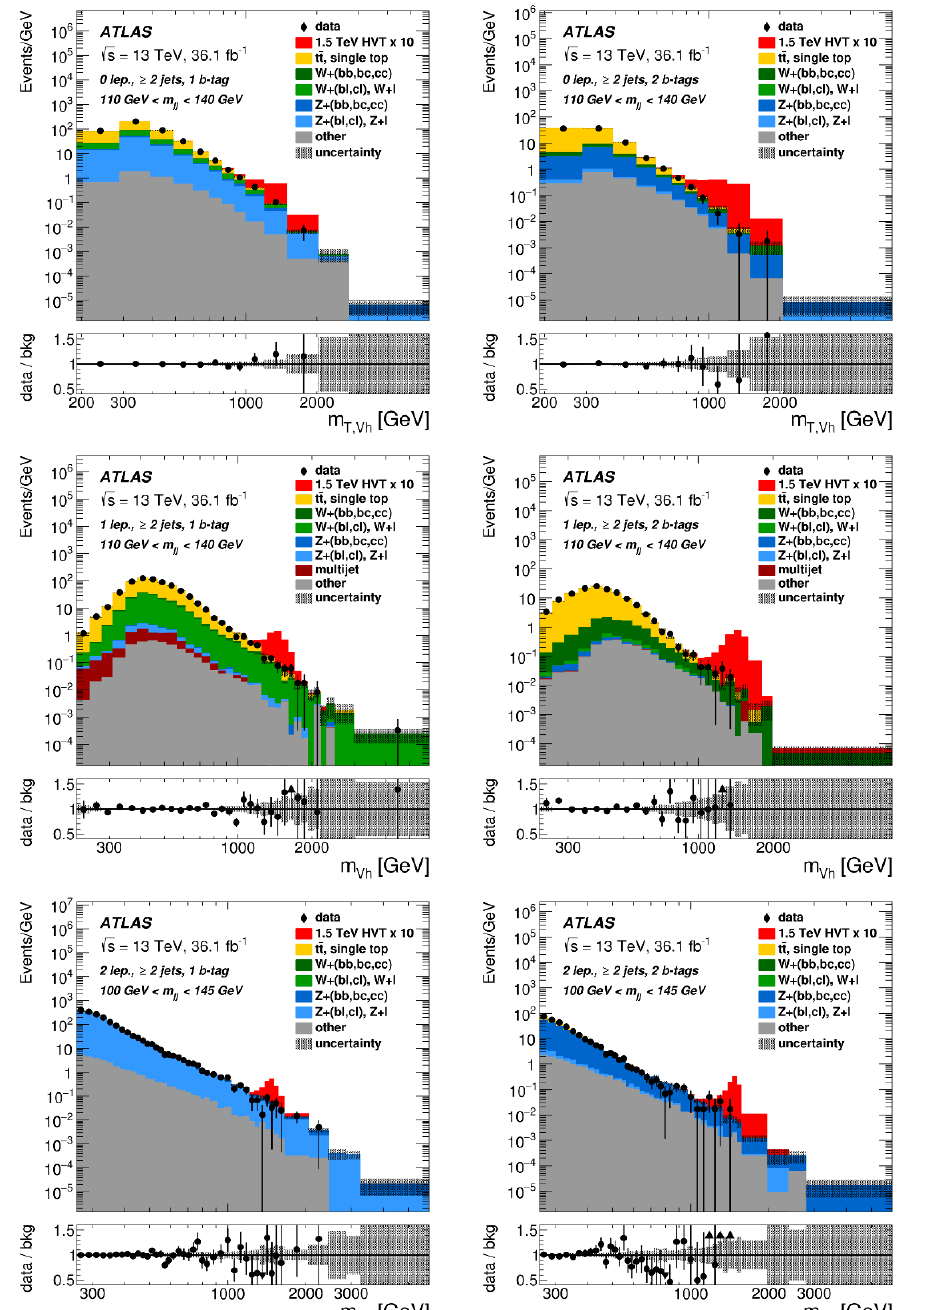
Figure 2. Event distributions of m T ;V h for the 0-lepton channel, and m V h for the 1-lepton and 2-lepton channels in the resolved categories. The quantity on the vertical axis is the number of data events divided by the bin width in GeV. The background prediction is shown after a background- only maximum-likelihood (cid:12)t to the data. The signal for the benchmark HVT Model A with m V 0 = 1 : 5 TeV is normalised to 10 times the theoretical cross-section. The background uncertainty band shown includes both the statistical and systematic uncertainties after the (cid:12)t added in quadrature. The lower panels show the ratio of the observed data to the estimated SM background.